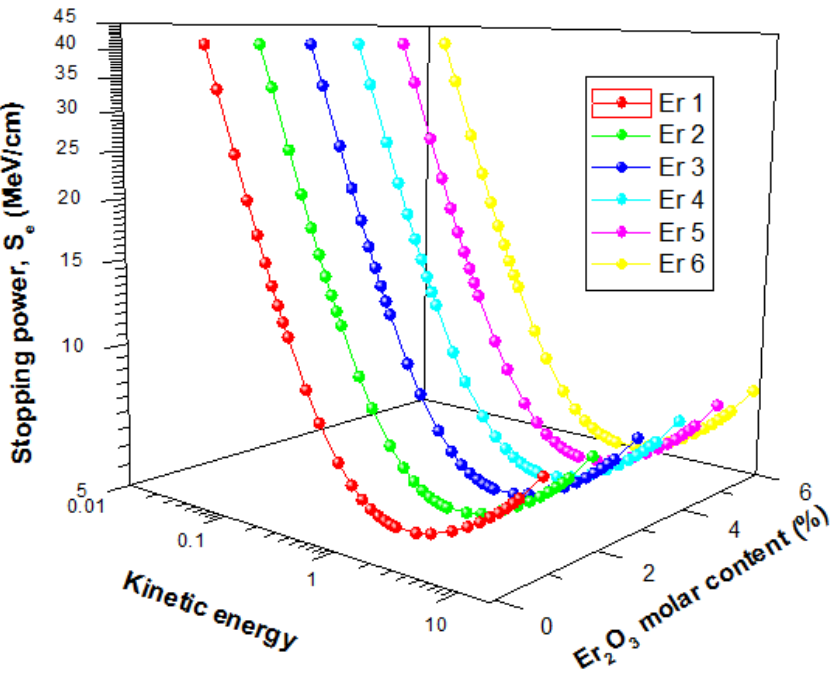
Figure 12. Stopping powers of Electron in the glasses as a function of kinetic energy.